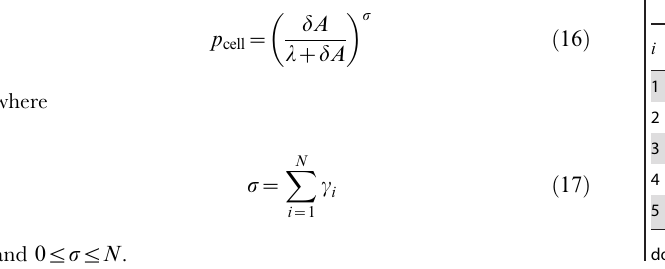
(Eq.(15)), and s for the i